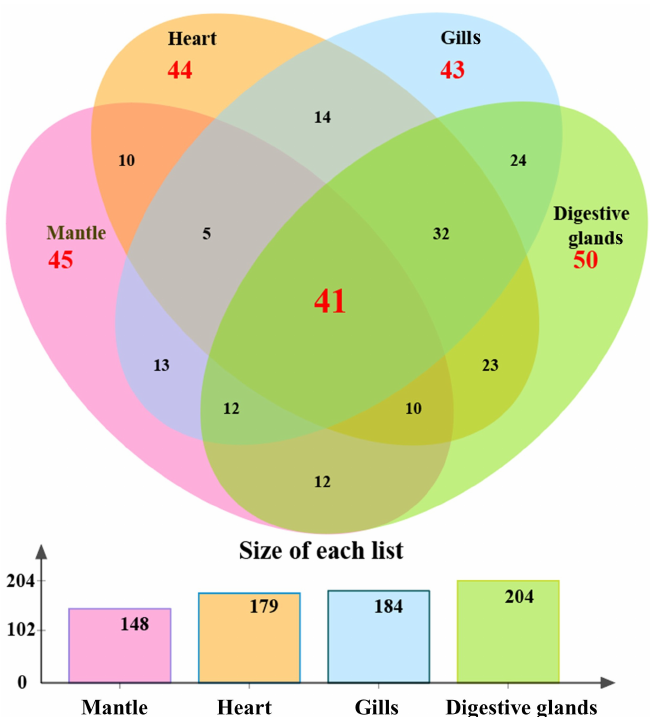
Figure 2. The distribution of 378 differential proteins in four tissues obtained by BSDS I.1P. Among them, 148, 179, 184, and 204 proteins were located in the mantle, heart, gills, and digestive glands, respectively. The amounts of 45, 44, 43, and 50 proteins were unique in each tissue. A total of 41 captured proteins were found in all